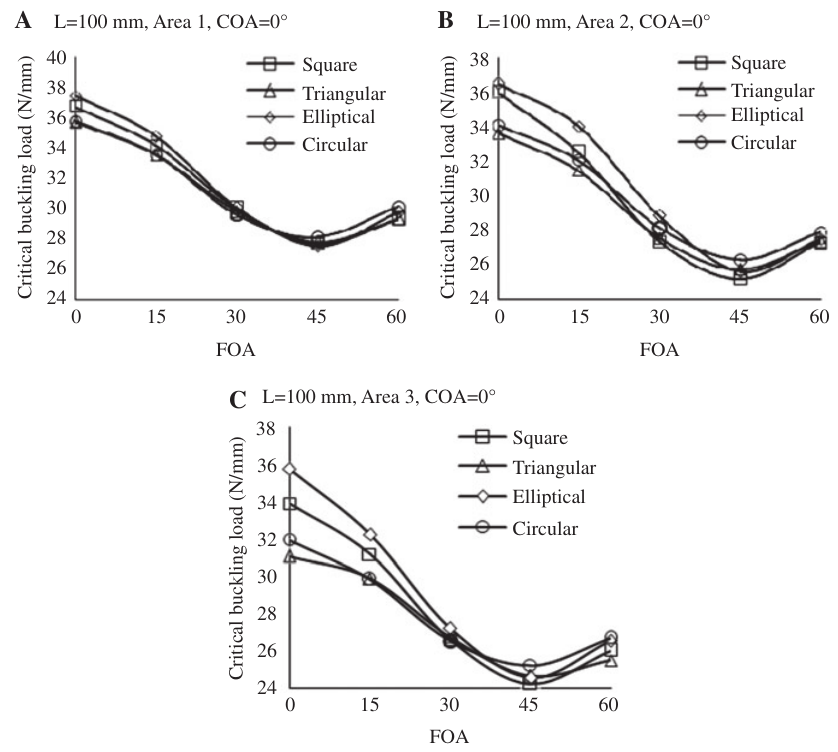
Figure 6 Effects of FOA on buckling load for L = 100 mm: (A) area 1, (B) area 2 and (C) area 3.